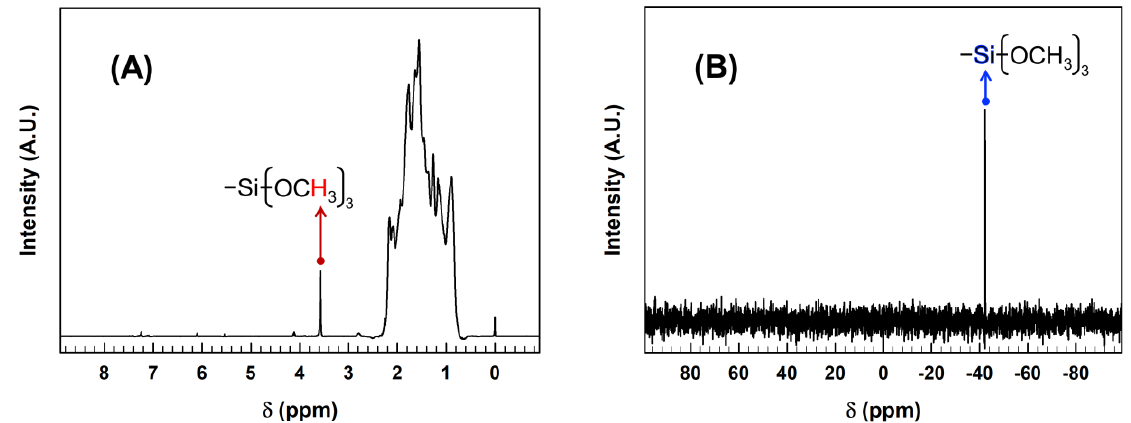
Figure 2. 1 H NMR ( A ) and 29 Si NMR ( B ) spectra for m -HCR.